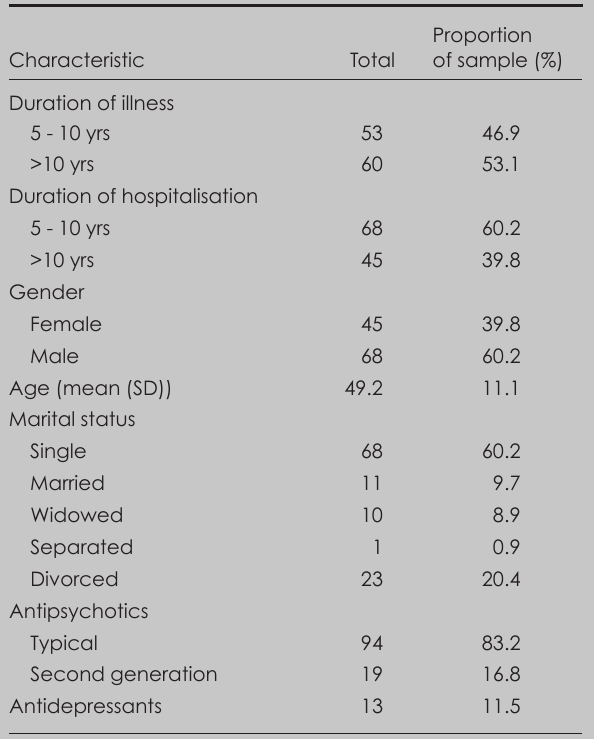
Proportion of sample (%)